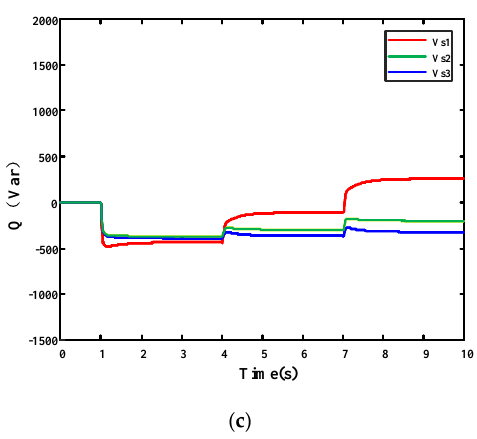
Figure 13. Simulation results of multiple ESs operating with the proposed control: ( a ) RMS value of PCC voltage; ( b ) active power; ( c ) reactive power.